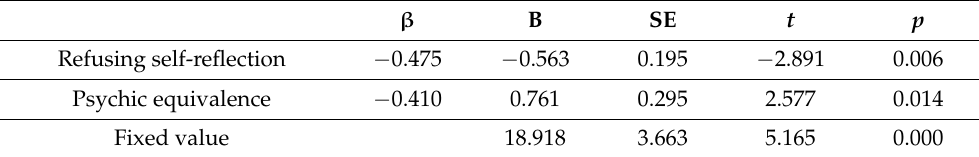
Table 13. Predictors of positive